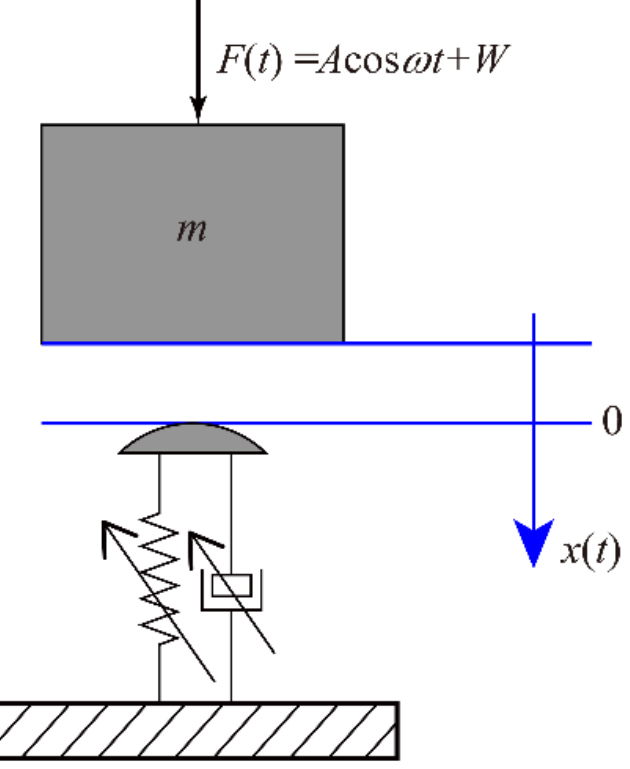
Figure 1. Power-form nonlinear one-sided contact system.